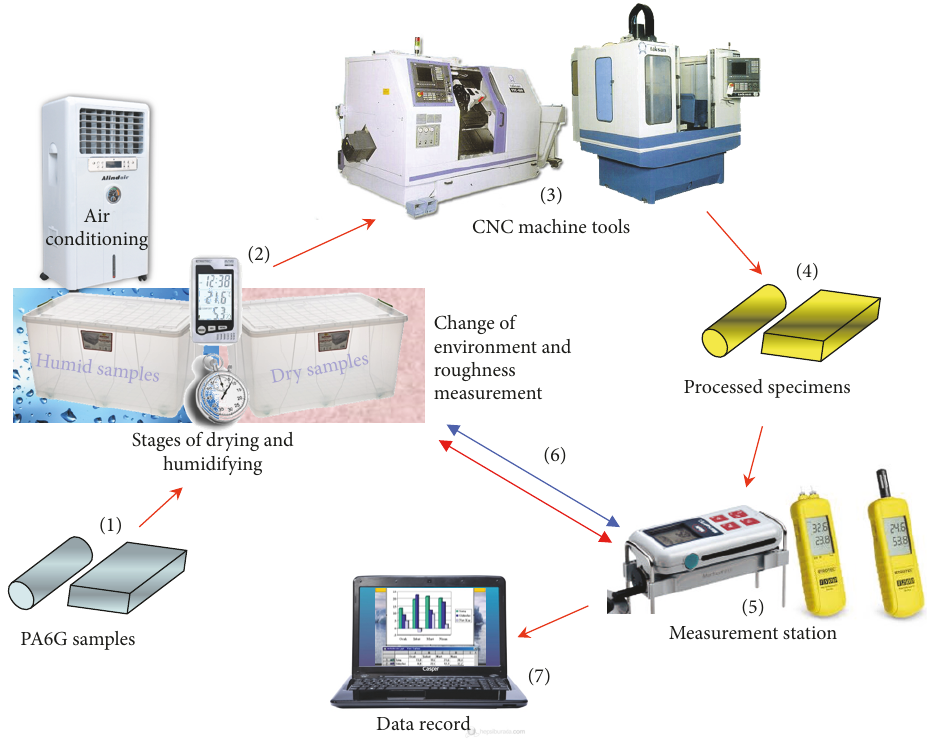
Figure 1: The scheme image of the experimental setup.